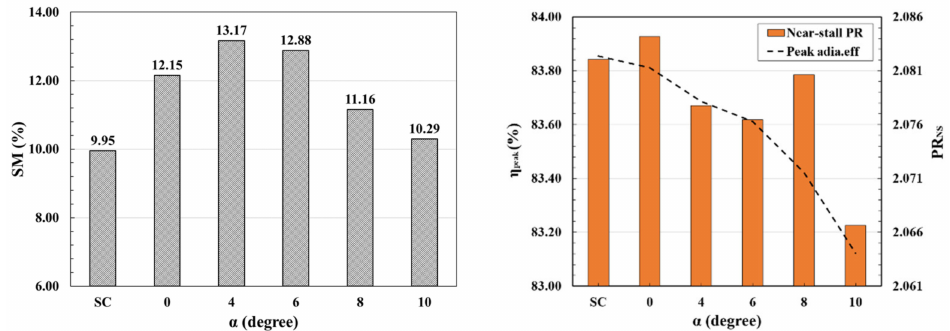
Figure 10. Effects of oblique angle on aerodynamic